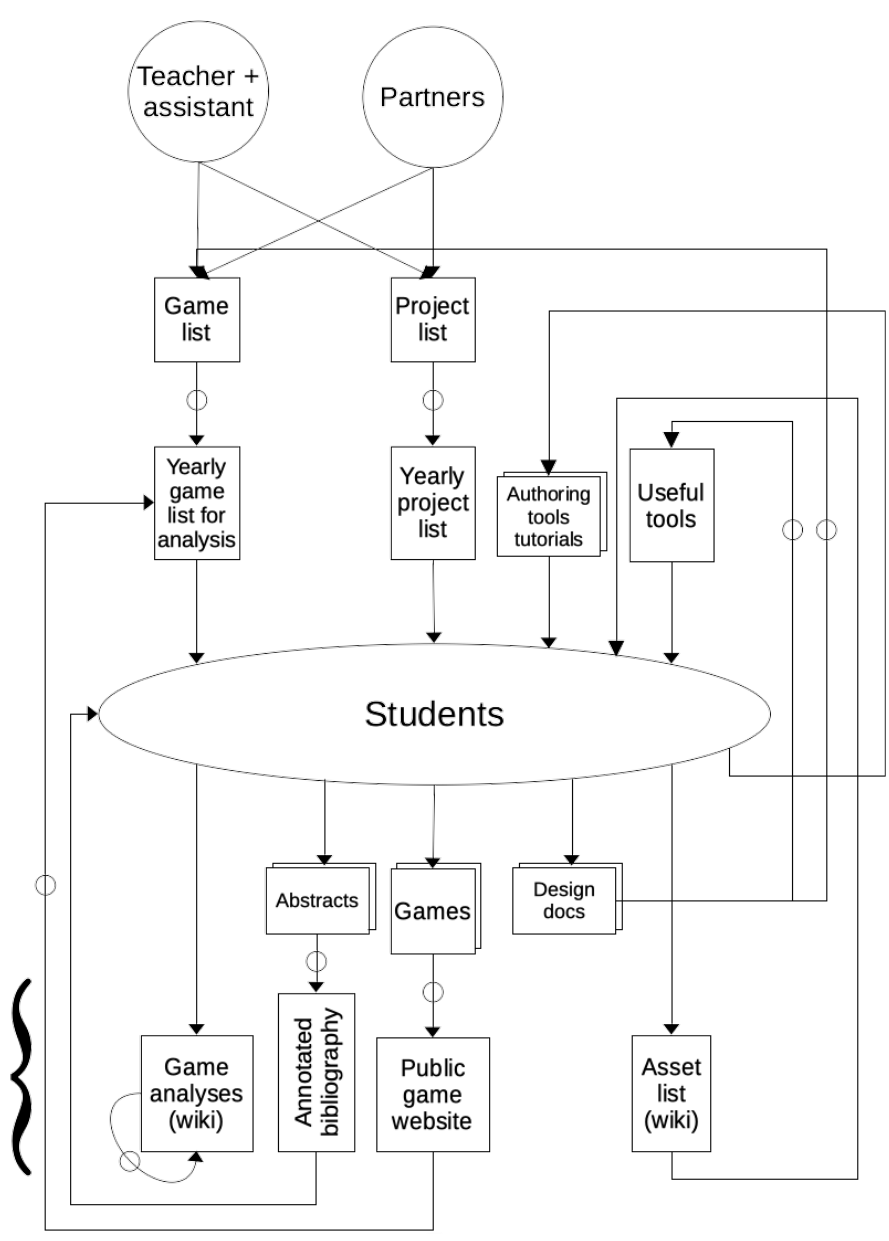
Fig. 1. Diagram illustrating the flow of student’s resources and productions. The central part represents the main design process of production (the project), while other deliverables are also included. Moderation is represented by a circle in the